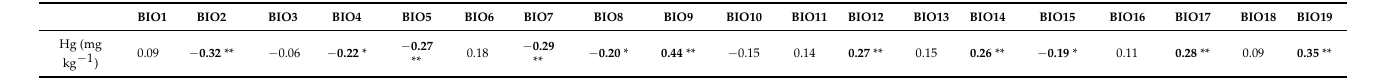
For explanation of abbreviations for bioclimatic variables, see Table 1. *: significant at p < 0.05; **: significant at p < 0.01.